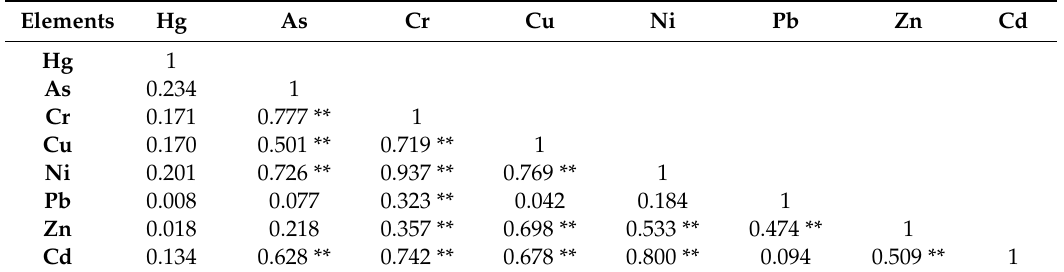
Table 6. Matrix of correlation coe ffi cient of eight elements in surface soils of northern